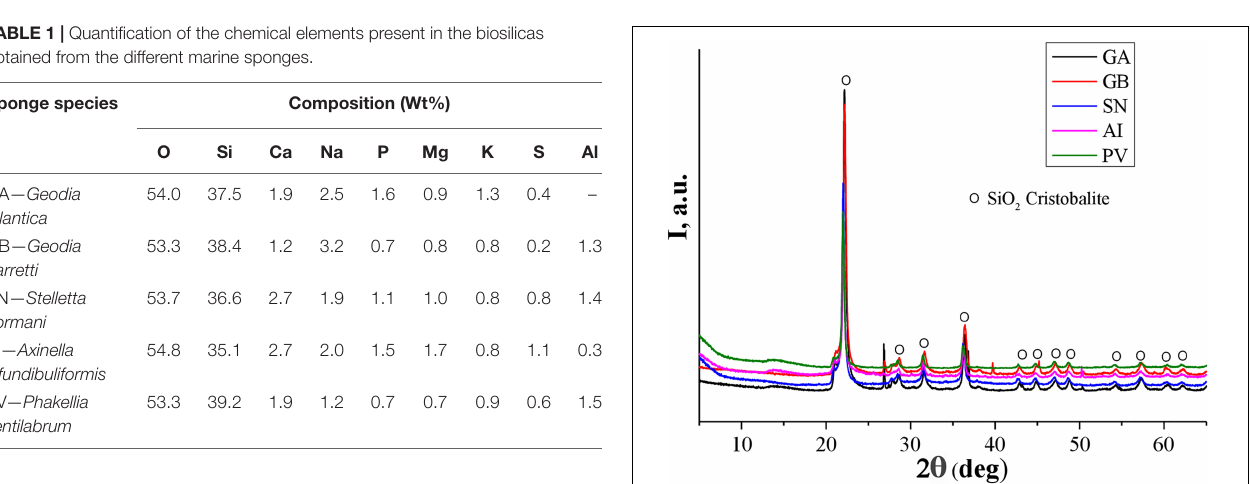
1 mL (Jones et al., 2001; Yu et al., 2012; Greasley et al., 2016), using aliquots of 15 mg of each biosilica per 10 mL of